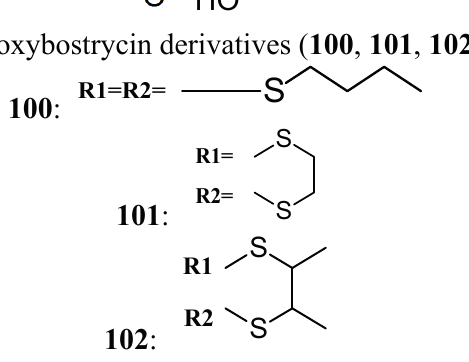
Figure 34. Bostrycin, deoxybostrycin and derivatives 97 – 102 .